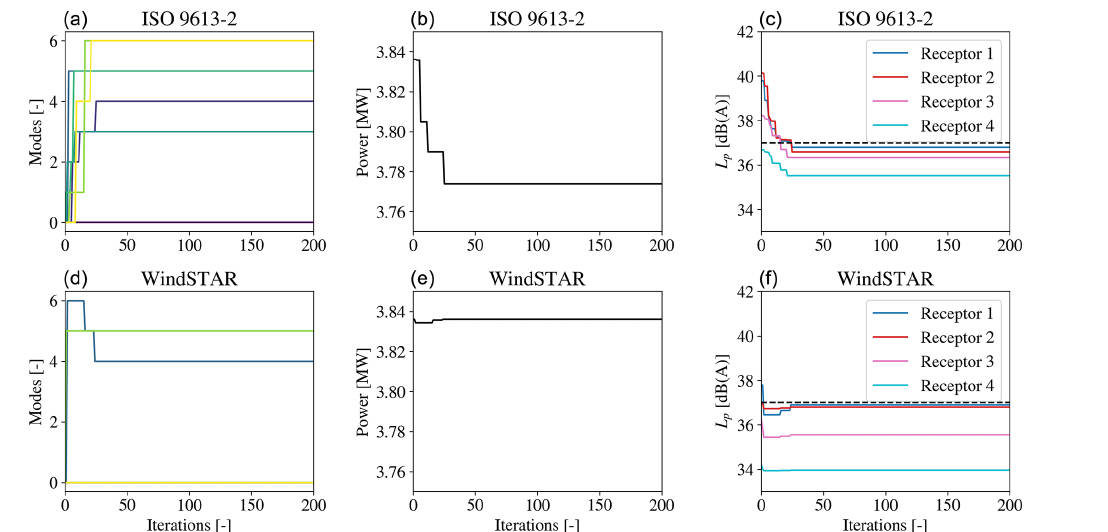
Figure 13. The operational mode, m i , for each wind turbine (a, d) ; the overall power of the seven SWT-2.3-93 wind turbines (b, e) ; and the integrated sound pressure level, L p , at each receptor (c, f) during the optimization at θ = 225 ◦ and U hub = 9 . 3ms − 1 . The noise constraint is set to L p , lim = 37dB(A) and represented by the dashed line in the right figure.